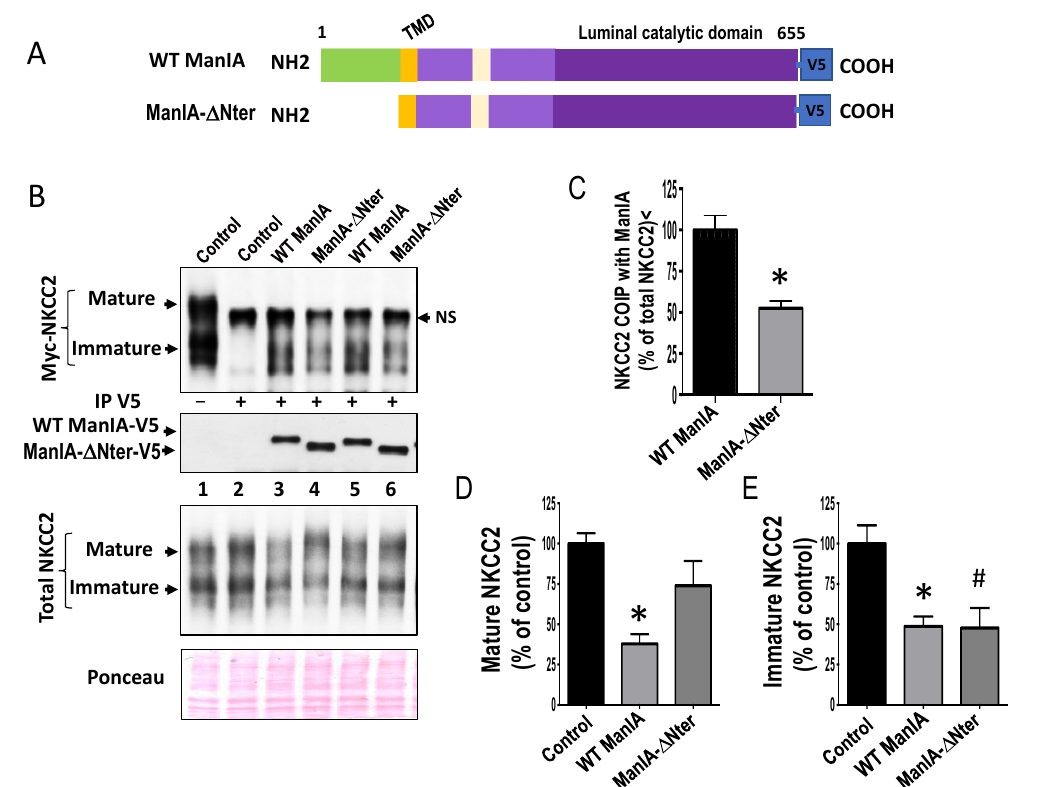
Figure 8. Role of the cytoplasmic domain of ManIA on its effect on NKCC2. ( A ) schematic of full-length of WT ManIA-V5 and the version of the protein truncated of its N-terminal cytoplasmic region (green). TMD, transmembrane domain. ( B ) Role of the cytoplasmic domain of ManIA on its interaction with NKCC2. HEK Cells were transiently transfected with Myc-NKCC2 either singly or in combination with WT ManIA-V5 or ManIA- Δ Nter. Cell lysates were immunoprecipitated (IP) with anti-V5 antibody. Co-immunoprecipitated and total NKCC2 and ManIA proteins were detected by immunoblotting using anti-Myc and anti-V5 antibodies. NS, non-specific. ( C ) quantitation of co-immunoprecipitated NKCC2 protein with WT ManIA or ManIA- Δ Nter normalized to total NKCC2 protein for each lane. ( D – E ) , Effects of WT ManIA and ManIA- Δ Nter on mature and immature NKCC2, respectively. densitometric analysis of mature ( D ) and immature ( E ) NKCC2 bands in the absence or presence of WT ManIA or ManIA- Δ Nter. Data were normalized to the indicated loading control (Ponceau staining) from the same lane in each membrane and are expressed as percentage of control ± S.E. * p < 0.03, # p < 0.05 versus control ( n = 4).